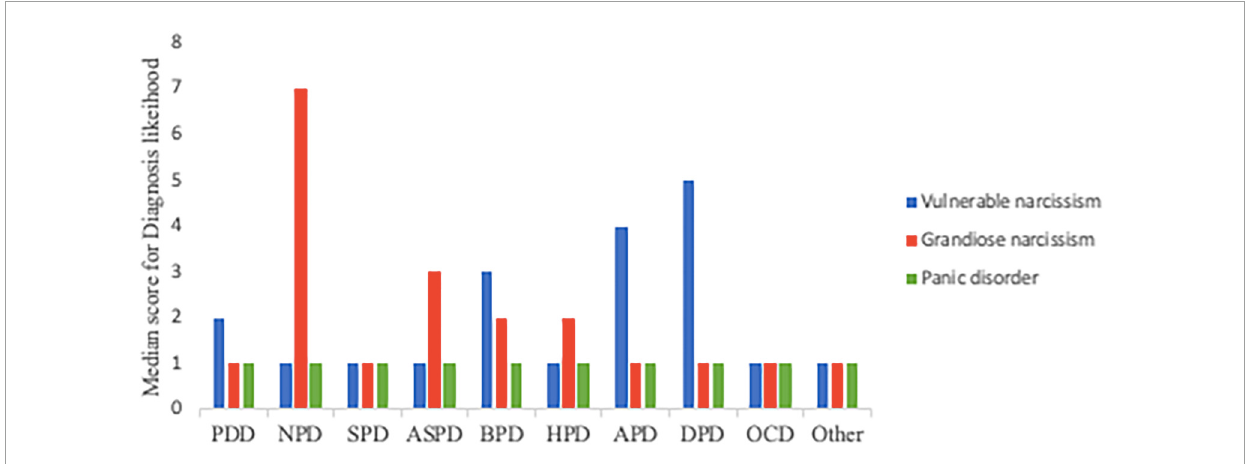
FIGURE1 Clinicians’ likelihood of diagnosis across three conditions. PPD, paranoid PD; NPD, narcissistic PD; SPD, schizoid PD; ASPD, antisocial PD; BPD, borderline PD; HPD, histrionic PD; APD, avoidant PD; DPD, dependent PD; OCD, obsessive-compulsive PD.